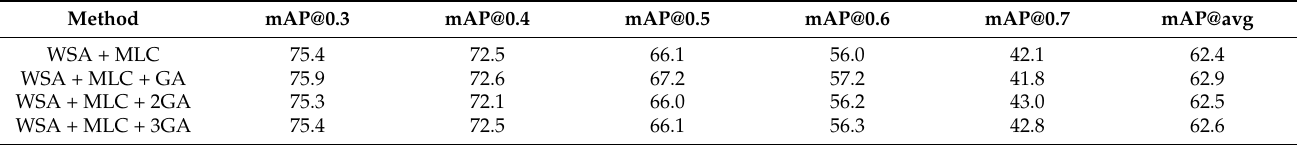
Table 6. Ablation study of different GA settings on THUMOS14 in terms of mAP(%)@tIoU.